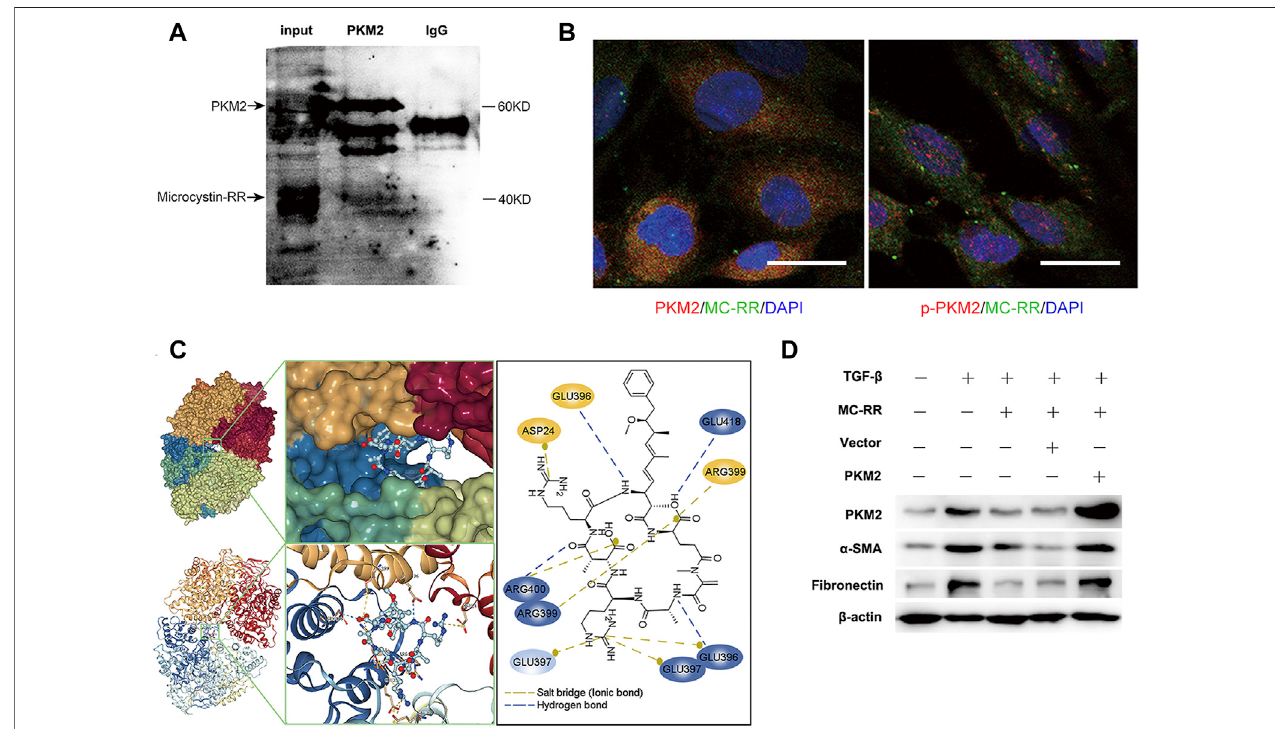
FIGURE6 | Microcystin (MC)-RR reduces thelevel ofpyruvate kinase M2 (PKM2) via interaction with PKM2. NRK-49F cells weretreated asexplained in Figure 4 . (A) Total protein extracted from the cultured NRK-49F cells pretreated with TGF- β 1 and MC-RR was immunoprecipitated with the PKM2 antibody. A protein band was subsequently identi fi ed as MC-RR by western blot. (B) Examination on colocalization of MC-RR (green) with PKM2 (red) or with p-PKM2 (red) was performed by immuno fl uorescence staining. DAPI was used for nuclear staining (blue) (scale bar: 20 μ m). (C) Interaction between PKM2 and MC-RR was predicted with molecular docking conducted using the Yinfo Cloud Platform. The hydrogen bonds (showed in broken blue line) and ionic bonds (in broken yellow line) were formed between the amino acid residues of PKM2 and MC-RR. (D) PKM2 rescue assay was performed by transfecting NRK-49F cells with the recombinant PKM2 expression plasmid (pcDNA3.1-PKM2). Control cells without transfection, vector (pcDNA3.1), and the pcDNA3.1-PKM2 transfected cells were treated as indicated for 48 h. The expressions of PKM2, α -smooth muscle actin ( α -SMA), and fi bronectin were detected by western